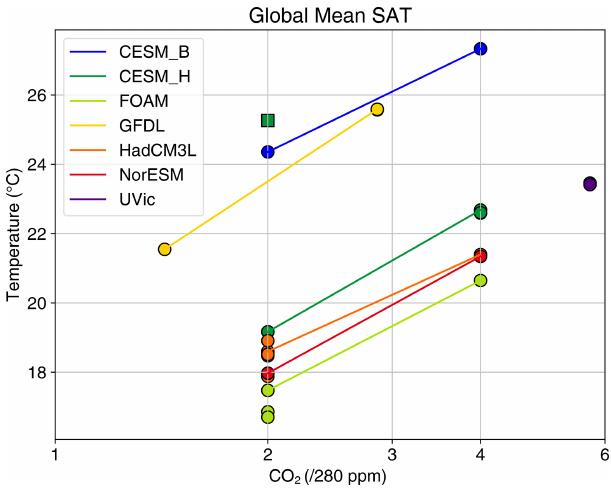
Figure 6. Global mean surface air temperature (SAT) for all mod- els included in this intercomparison as a function of CO 2 concentra- tion. The lines join simulations from a single model at different CO 2 concentrations. References for each model are CESM_H: Goldner et al. (2014); UVic: Sijp et al. (2016); FOAM: Ladant et al. (2014a, b); GFDL: Hutchinson et al. (2018, 2019); HadCM3BL: Kennedy et al. (2015); NorESM-L: Zhang et al. (2014); and CESM_B: Baat- sen et al. (2020). The dark green square is an additional simulation of CESM_H with 2 ◦ atmosphere resolution (Table